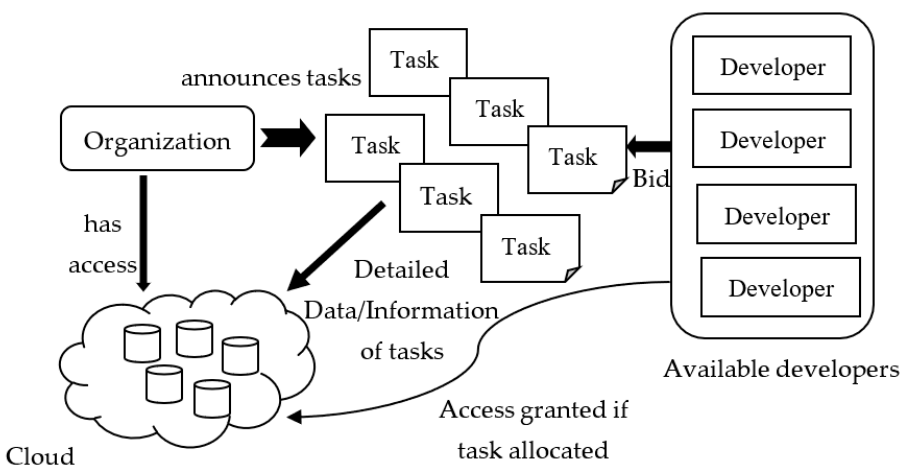
Figure 1. The proposed TaskAuc architecture.